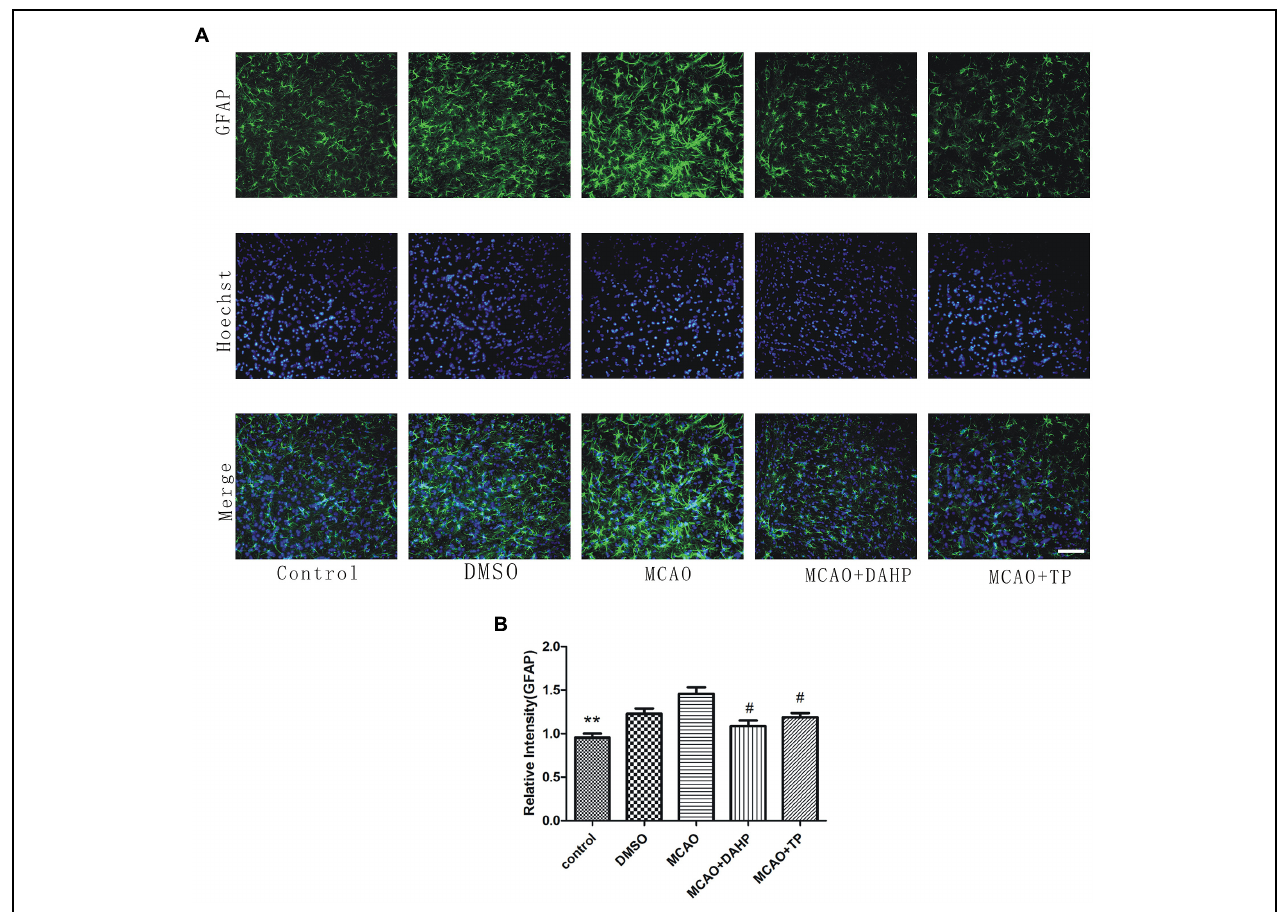
FIGURE 4 | 2, 4-diamino-6-hydroxypyrimidine and TP treatments attenuated ‘reactive gliosis’ in the ischemic area. (A) Immuno- fluorescence staining showed immunoreactivities of GFAP after MCAO. The profound expression of GFAP was observed in MCAO group